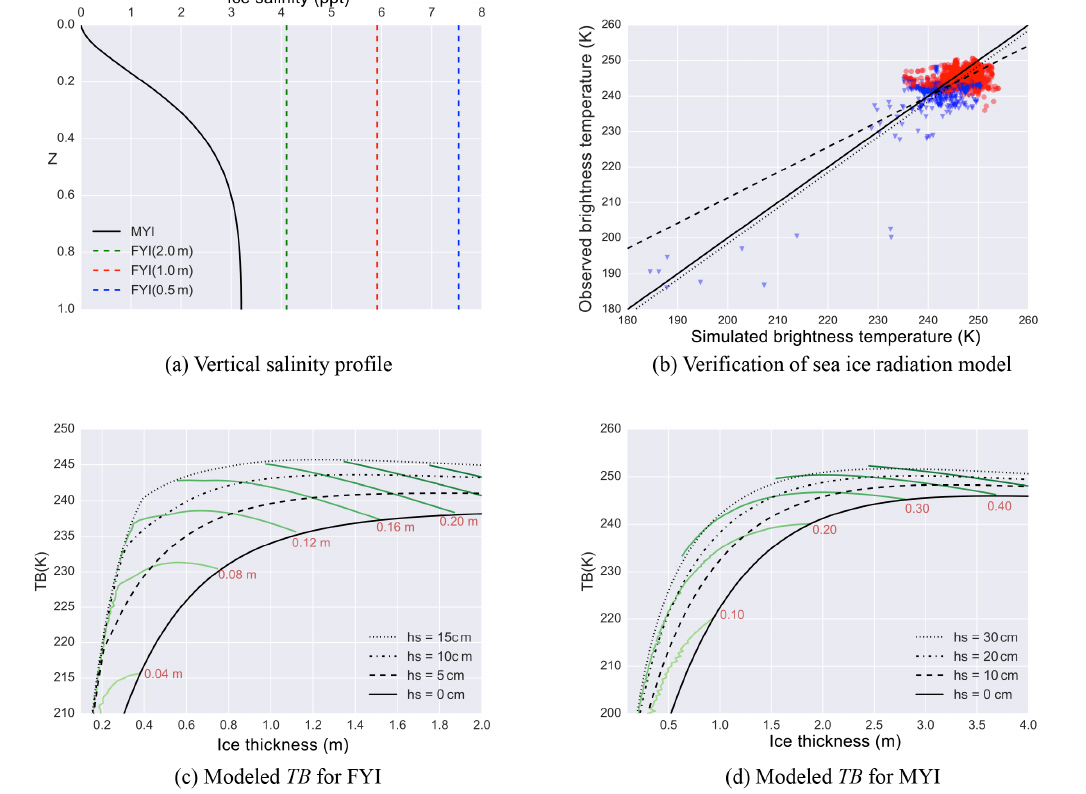
Figure 3. L-band radiation model. Panel (a) shows sea ice salinity profile for FYI (dotted lines) and MYI (solid line). The vertical axis ( z ) is normalized with respect to the sea ice thickness. The comparison of the simulated TB based on OIB data and the observed SMOS TB is presented in panel (b) . Blue triangles represent FYI, while red circles are MYI. The dashed (dotted) line is the least squares fit (least squares fit under the constraint that slope is 1). The root mean square error of TB is 3.1K. Panels (c) and (d) show the modeled TB under typical sea ice parameters ( h i and h s ), assuming Arctic winter conditions (surface temperature of − 30 ◦ C). The green lines represent constant snow freeboard